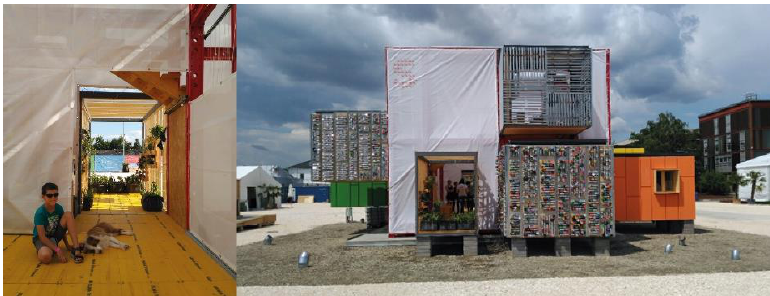
Figure 2. Interior photograph and a view from façade/Aura Prototype 3.1.